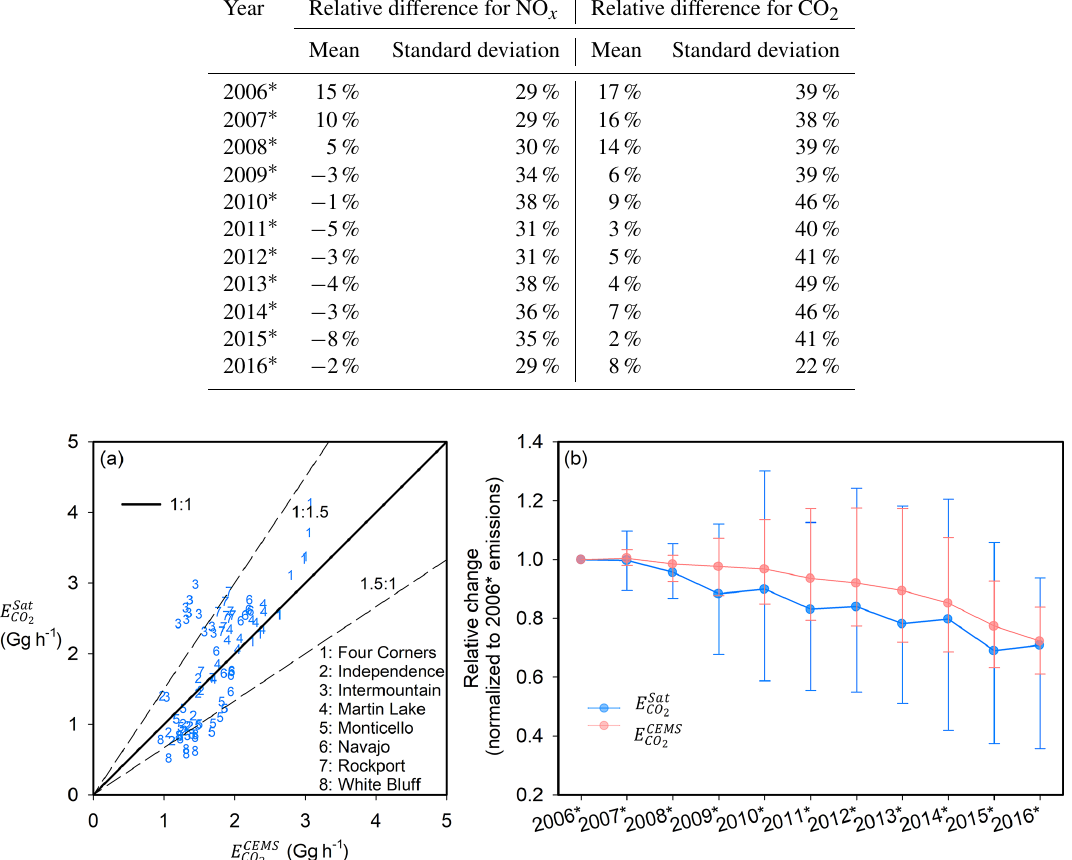
Table 3. Summary of relative difference between satellite-derived NO x emissions ( E Sat derived CO 2 emissions ( E Sat ), and bottom-up CO 2 emissions ( E CEMS CO 2 2017. The 3-year periods are represented by the middle year with an asterisk.